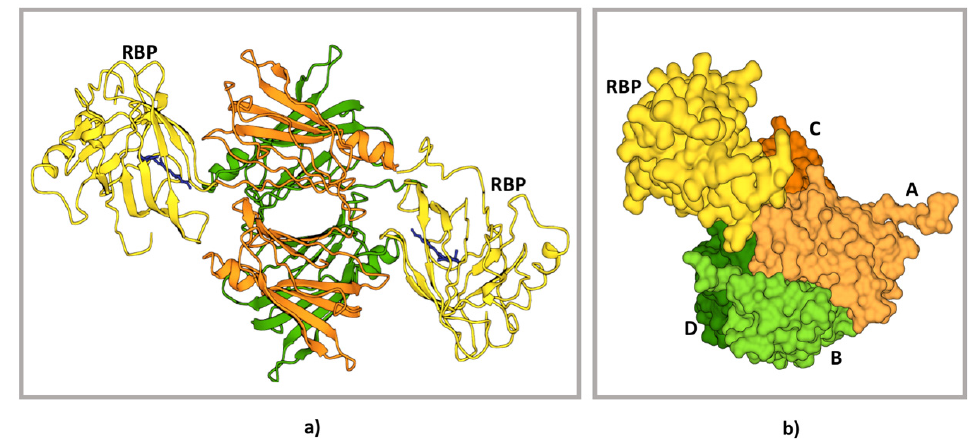
Figure 3. Structure of TTR–RBP complex. ( a ) Structure representation of the TTR–RBP complex. TTR: monomers A and C, orange; monomers B and D, green. RBP: yellow. Retinol: blue ( b ) Detail of the contact between the TTR subunits A, C, and D and the RBP molecule [left side, colour codes as in ( a )]. Centre and right drawings show the interacting surfaces of RBP (centre) and of the TTR subunits A, C, and D (right). It is possible to appreciate how the RBP surface fits into a site formed by the arrangement of three TTR subunits (A, C, and D). The figure has been produced using “www.rcsb.org” web site, access date 22 June 2022.